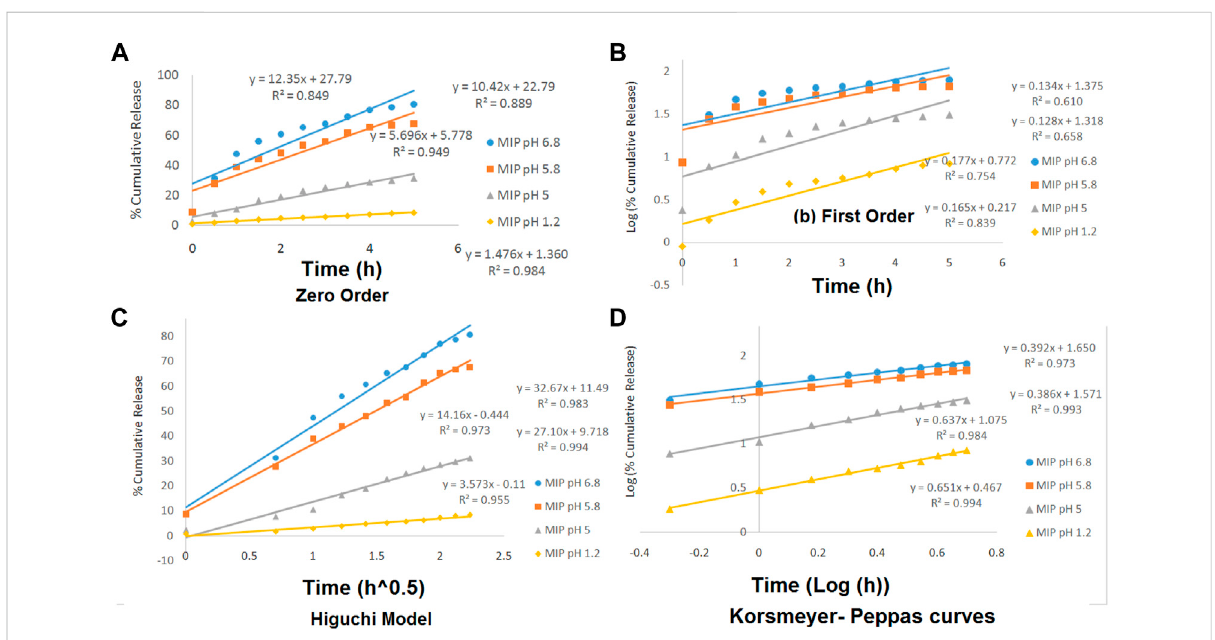
FIGURE 6 Zero-order (A) , the fi rst-order (B) , the Higuchi model (C) , and the Korsmeyer – Peppas (D) curves for MIP at various pH levels of 1.2, 5, 5.8, and